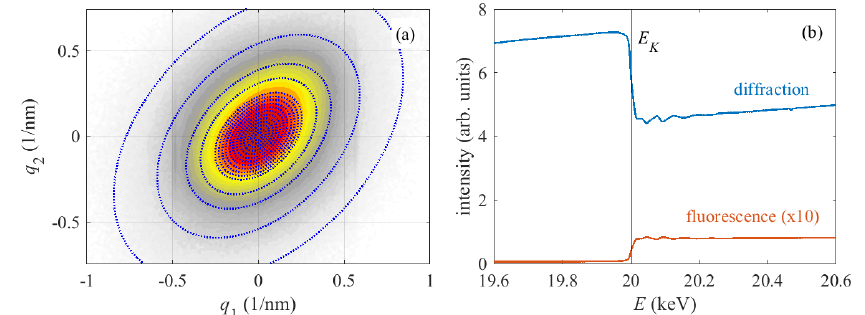
Figure 2. ( a ) Diffraction maximum h = ( 44¯82 ) ω displayed as one detector frame taken at E = 19.96 keV, sample annealed at 370 ◦ C for 64 h. The intensity is plotted in logarithmic scale, the colors from white to dark red span over four decades. q 1,2 denotes the coordinates in reciprocal space parallel to the detector plane, q 1 = q 2 = 0 corresponds to the reciprocal-lattice point h . The elliptical ROIs are displayed by blue dotted lines. ( b ) Energy dependence of the diffraction signal taken from the largest ROI (blue) and the fluorescence background (red, enlarged). The vertical black line expresses the absorption-edge energy E K